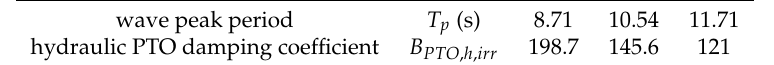
Table 4. Optimal hydraulic damping coefficients B PTO , h , irr for a single OSWEC (10 6 × m 2 ·